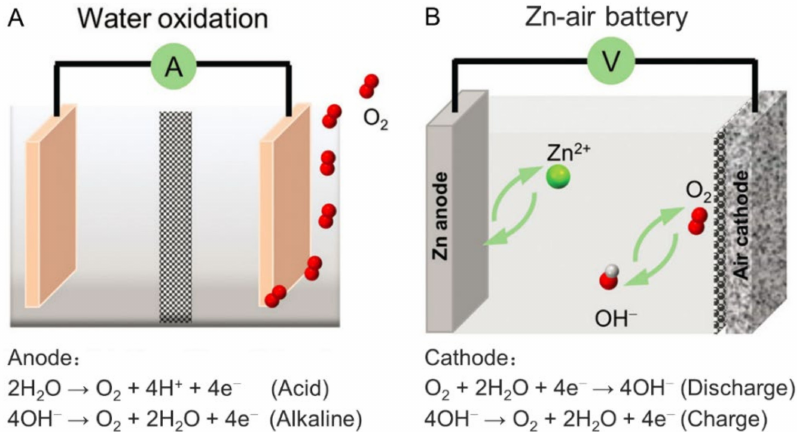
Figure 1. Schematic illustrations of representative devices for electrochemical OER: ( A ) water- splitting electrolytic cell and ( B ) rechargeable Zn–air battery. Reprinted with permission from ref. [28]. Copyright The Royal Society of Chemistry